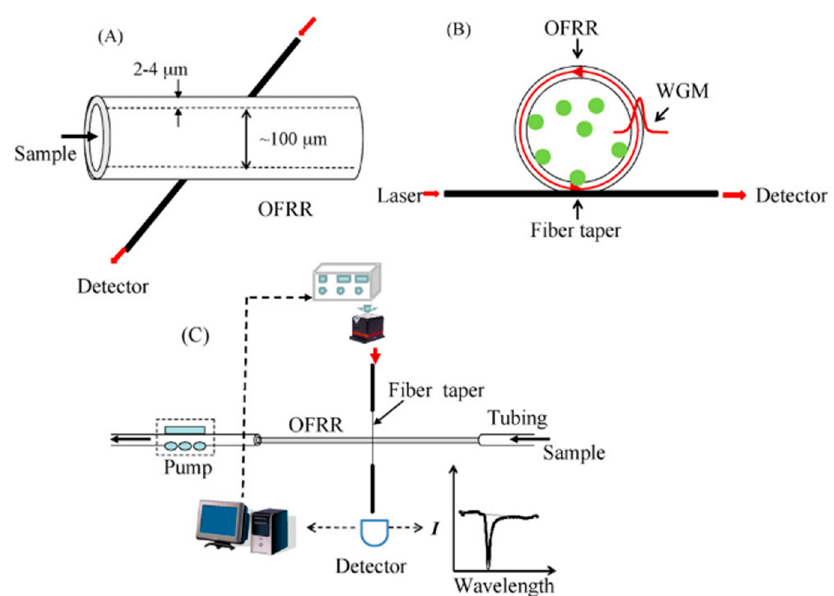
Figure 11. Scheme of optofluidic ring resonator (OFRR) sensor. ( A ) OFRR consists of a glass capillary with an ultra-thin wall (2–4 nm) and lumen about 100 µm in diameter. ( B ) Whispering gallery modes (WGMs) may be investigated by a laser directed on the OFRR. ( C ) Schematic of the apparatus required to run an OFRR sensor. [62] Reprinted from [62], Copyright 2008, with permission from Elsevier.